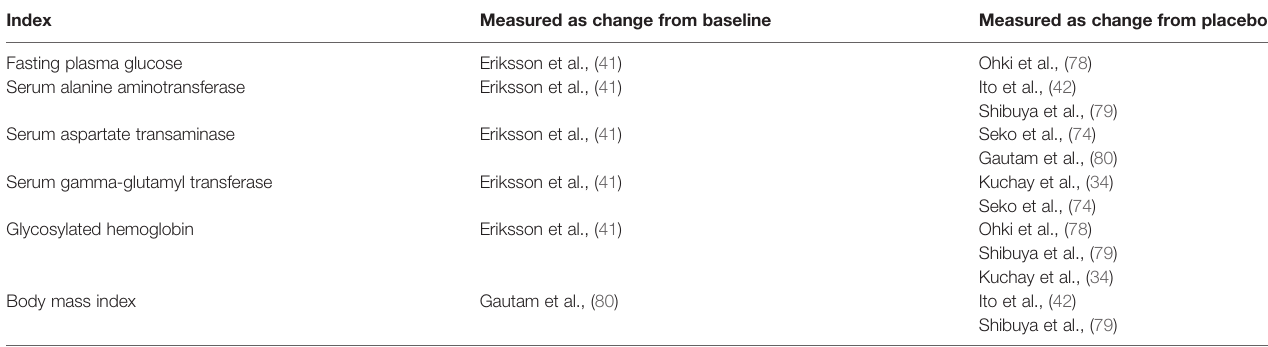
TABLE 1 | Outcome measures commonly recorded in studies of the ef fi cacy of SGLT-2 inhibitors in patients with concurrent type 2 diabetes mellitus and non-alcoholic steatohepatitis. Index Measured as change from baseline Measured as change from placebo Fasting plasma